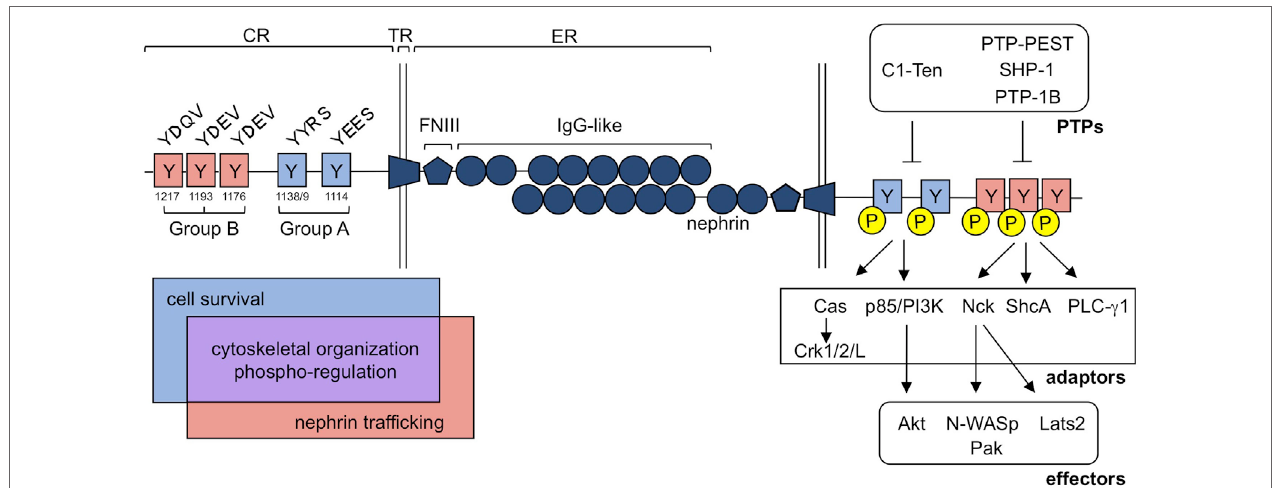
FiGURe 2 | Nephrin tyrosine phosphorylation regulates a diverse group of signaling processes within the podocyte. Nephrin is a single pass transmembrane protein and contains a singular extracellular (ER), transmembrane (TR), and cytoplasmic (CR) region. Nephrin’s ER contains 1 Fibronectin-like III (FNIII) motif and eight Immunoglobulin (IgG)-like regions, which allow for homophilic interactions of nephrin molecules in trans . Tyrosine residues embedded in nephrin’s CR can be loosely classified into two categories, denoted as group A or B tyrosines, based largely on their flanking sequences. These consensus sequences are conserved and influence the adaptor molecules and downstream signaling effectors that can be recruited to nephrin upon their tyrosine phosphorylation. Interactions with each group contributes to cytoskeletal organization (through Cas-Crk/1/2/L, Nck-N-WASp/Pak and/or PLC- γ 1) and nephrin’s phospho-regulation [through protein tyrosine phosphatases (PTPs)], denoted in purple. Alternatively, cell survival signaling appears to be largely restricted to signaling at group A residues (through p85/PI3K-AKT), denoted in blue, while nephrin trafficking is influenced by group B signaling (through ShcA), denoted in red.